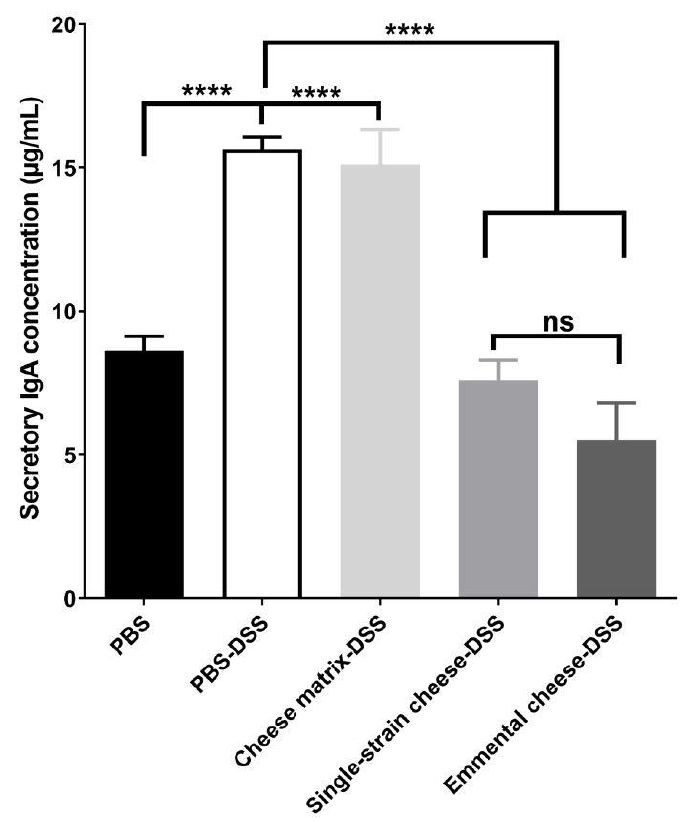
Figure 5. Impact of cheese matrix, single-strain cheese and Emmental cheese intake on small bowel IgA secretion. Secretory IgA concentration in the small bowel content was determined by ELISA quantification. The data represent the mean ± SD of 18 mice per group. Groups were as follows. PBS: healthy group gavaged using PBS bu ff er as a sham. PBS-DSS: DSS-treated-colitis control group gavaged using PBS bu ff er as a sham. Cheese matrix-DSS: DSS-treated group gavaged using a germ-free dairy matrix. Single-strain cheese-DSS: DSS-treated group gavaged using an experimental single-strain cheese containing P. freudenreichii CIRM-BIA 129 as a sole bacterium. Emmental-DSS: DSS-treated group gavaged using an industrial Emmental cheese produced using P. freudenreichii CIRM-BIA 129 as a ripening starter. Multiple comparisons were performed, * p < 0.05, ** p < 0.01, *** p < 0.001 **** p < 0.0001.